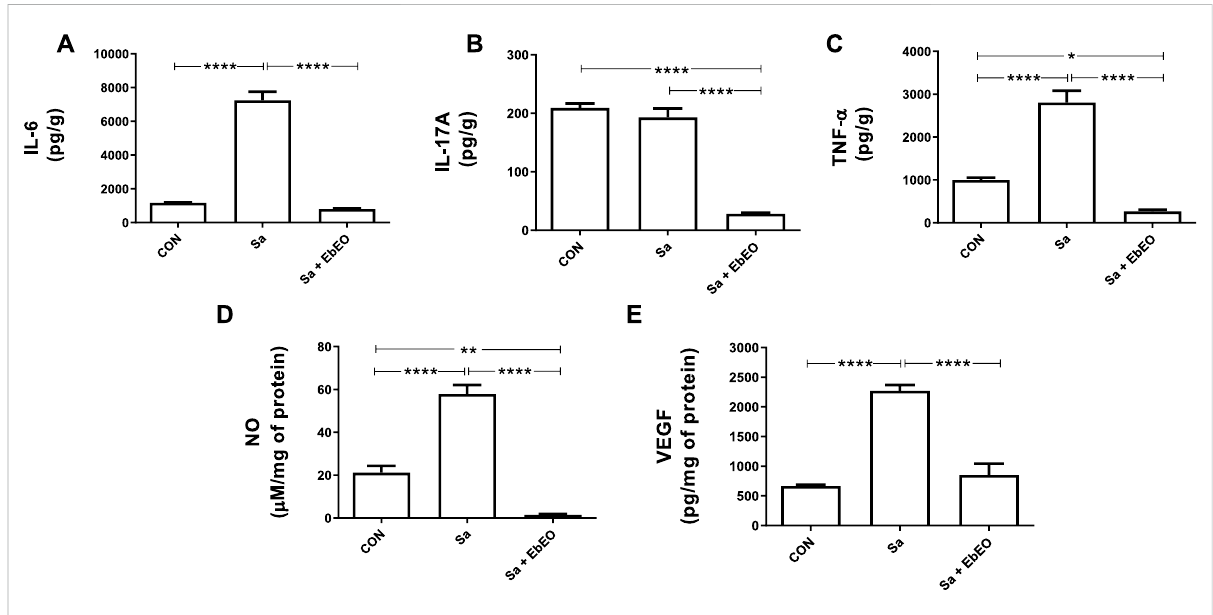
FIGURE 4 Effect of topical treatment with Eugenia brejoensis essential oil on in fl ammatory markers present in the tissue of wounds contaminated by Staphylococcusaureus . (A) AmountofIL-6atwoundtissue; (B) AmountofIL-17Aatwoundtissue; (C) AmountofTNF- α atwoundtissue; (D) Amount of NO at wound tissue; (E) Amount of VEGF at wound tissue. * p < 0.05; ** p < 0.01; **** p <